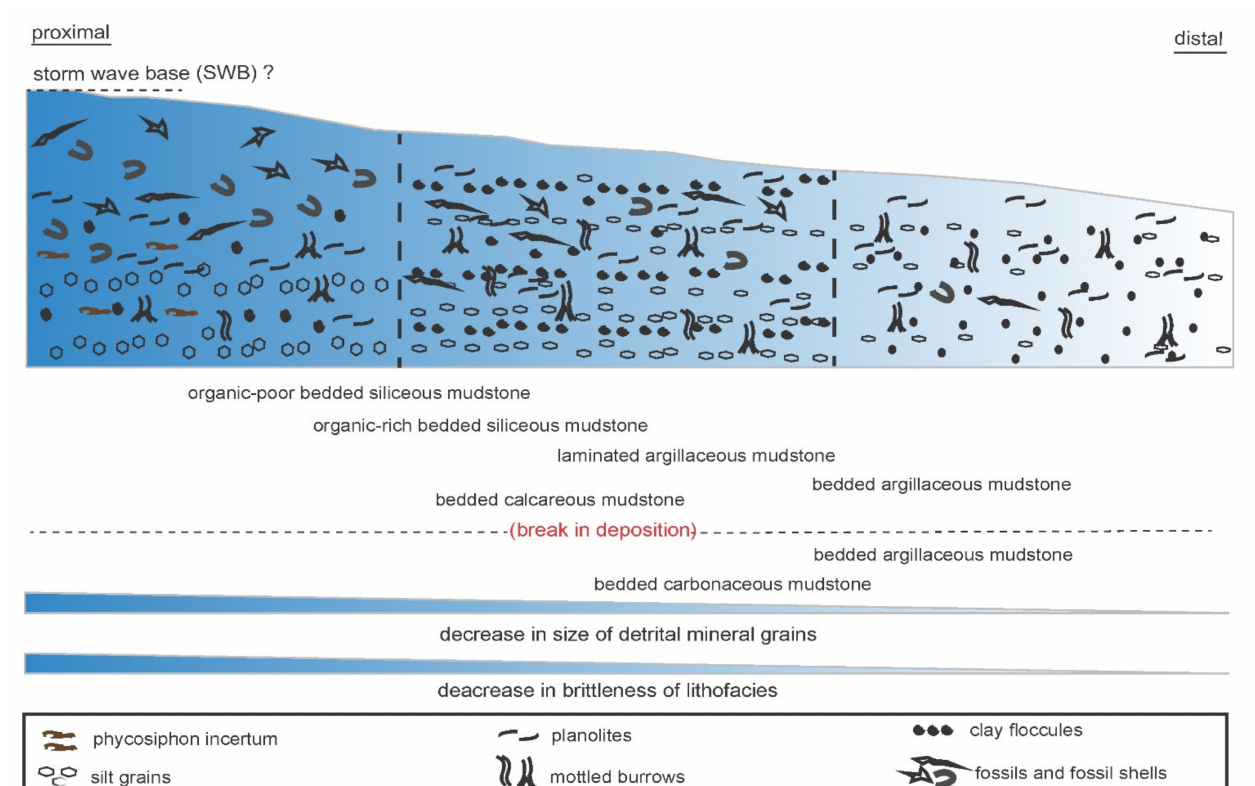
Figure 8. Conceptual model showing the distribution of mudstone lithofacies and burrow types along the facies belt. Note the decreasing trend in grain size of detrital mineral grains and brittleness of the lithofacies from the proximal to the distal zone